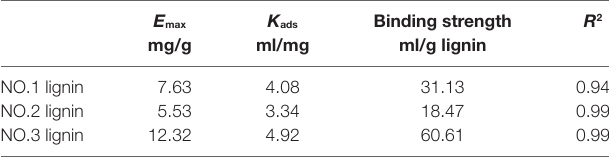
Table 5 | Langmuir adsorption isotherm parameters from CBH adsorption to lignins.